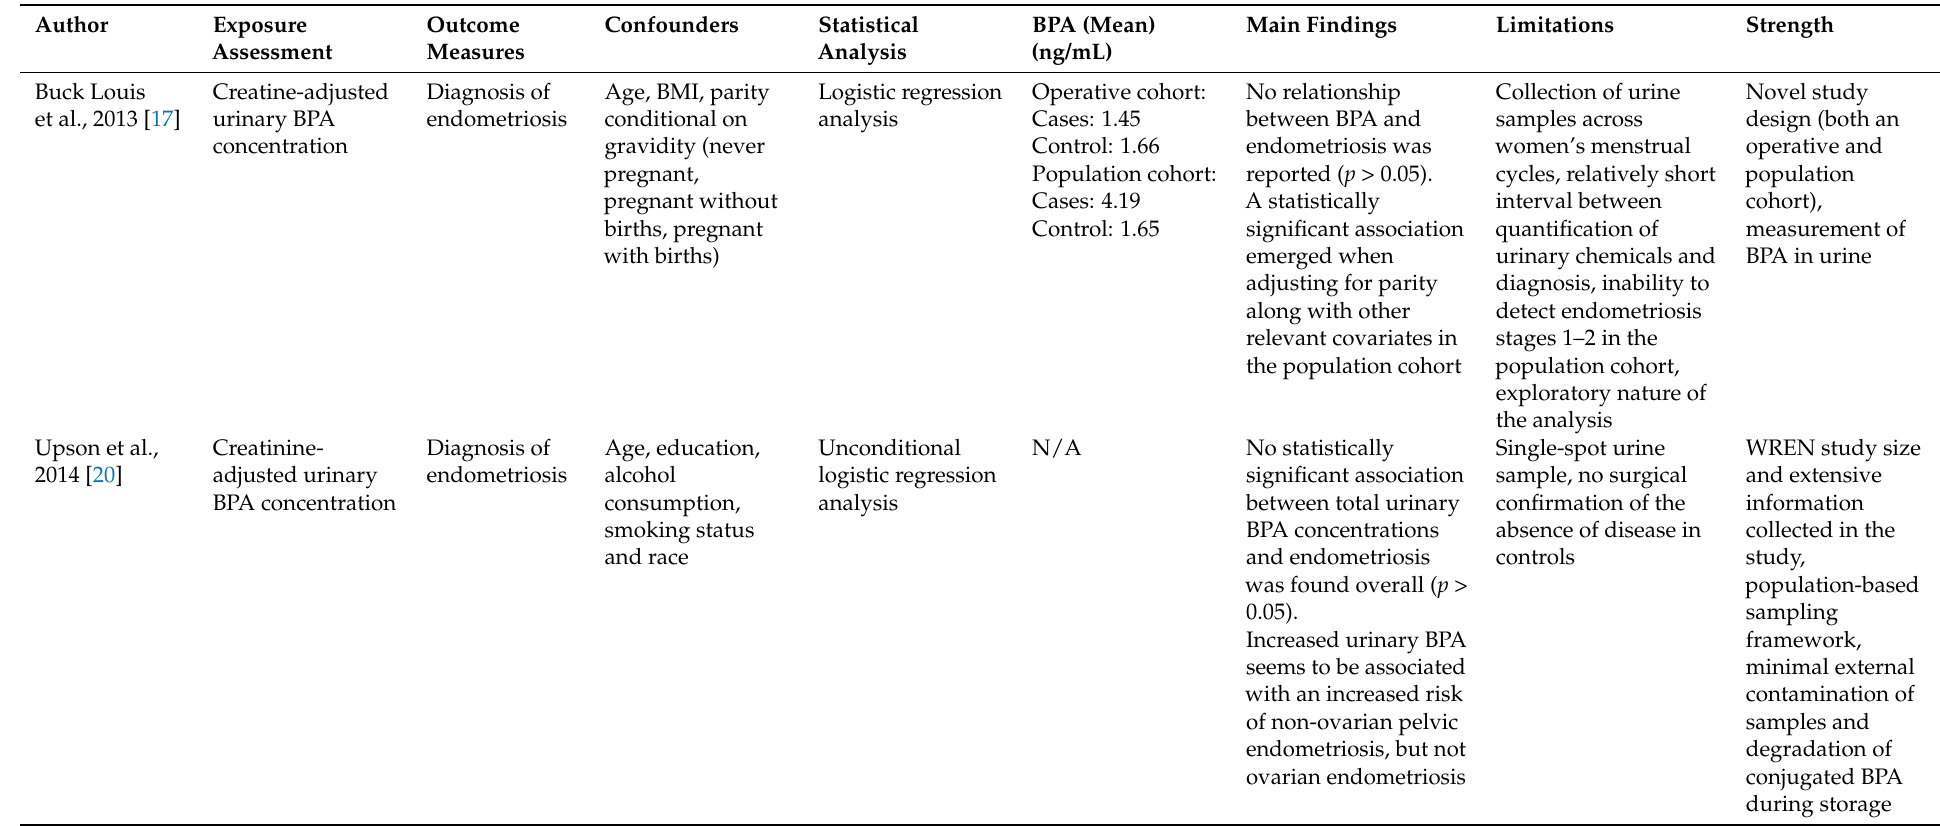
Table 4. Bisphenol-A (BPA) and